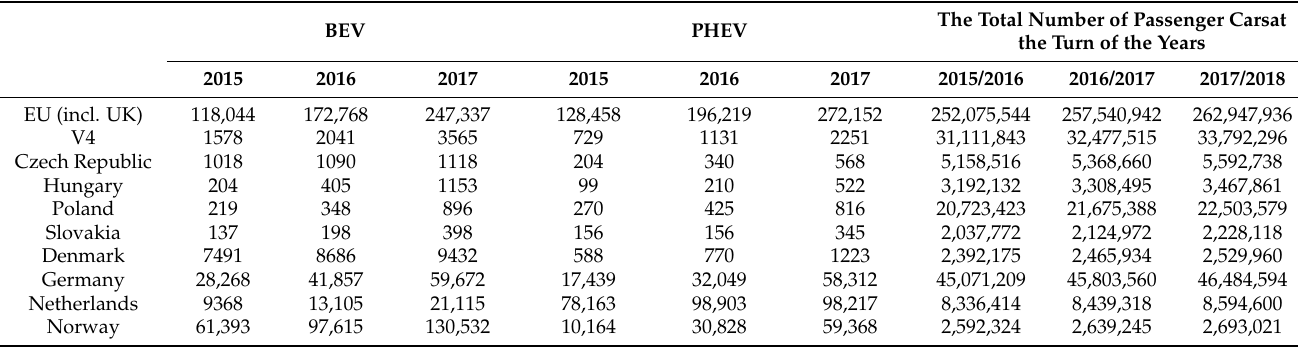
Table 1. The total number of passenger cars, BEVs (battery electric vehicles) and PHEVs (plug-in hybrid electric vehicles) in 2015–2017, (source: elaborated by authors based on [16,25]). BEV PHEV